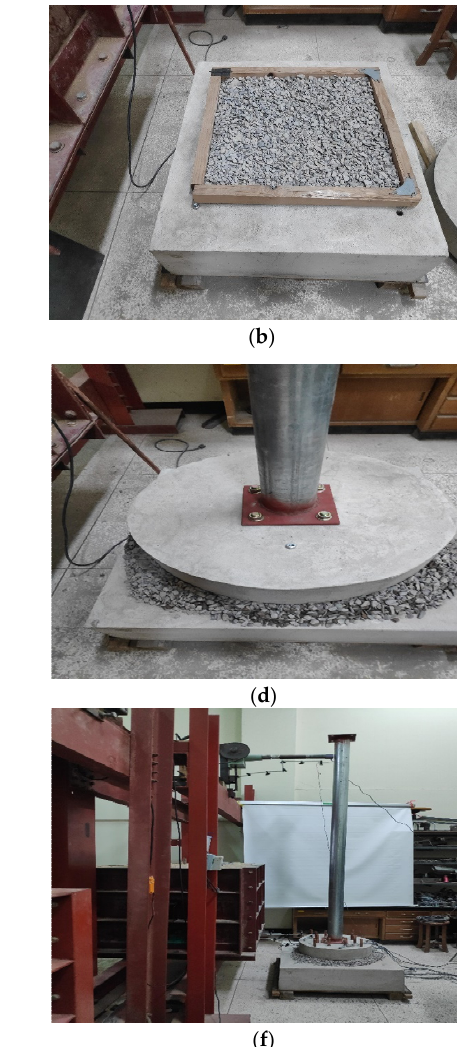
Figure 6. Layout of model experiment apparatus. 3. Results and Consideration of Modeling Experiment 3.1. Lateral Resistance Figure 7 is a comparison of the lateral resistance forces according to foundation form. When there are no piles (Case 1, 2), horizontal displacement measured up to 25 mm, at which the lateral resistance force converged to a constant value. The lateral resistance Reactionframe